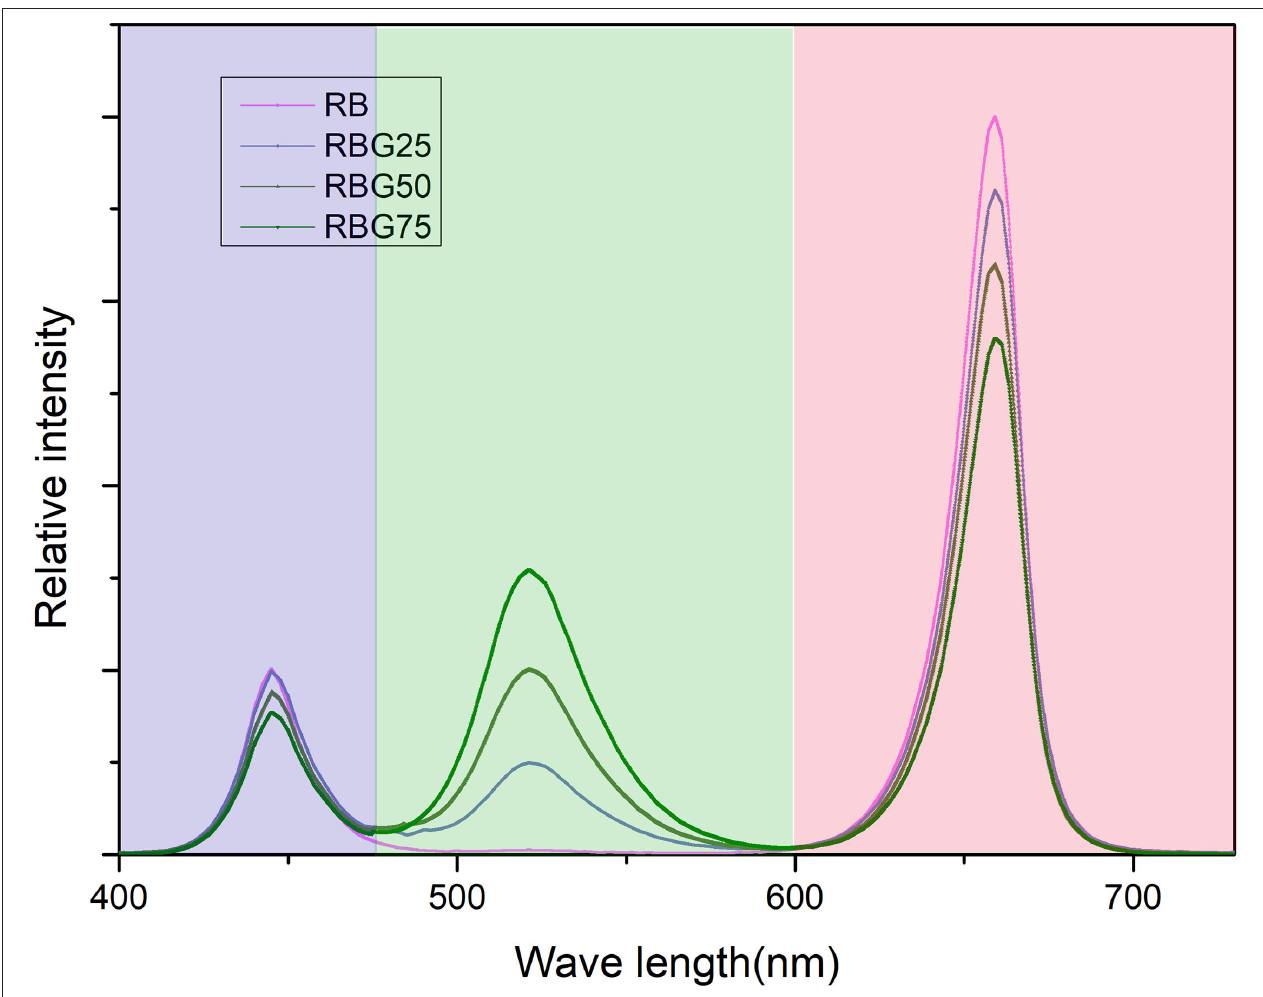
FIGURE 1 | The relative spectral distribution of four LED treatments measured at the top of the canopy. The four LED treatments contained red + blue (RB), red + blue + 25 µ mol m − 2 s − 1 green (RBG25), red + blue + 50 µ mol m − 2 s − 1 green (RBG50), red + blue + 75 µ mol m − 2 s − 1 green (RBG75) LEDs. Light qualities were indicated according to wavelengths: red (peak at 660nm), blue (peak at 450nm), and green (peak at 530nm). The photosynthetic photon flux density (PPFD) of all treatments was maintained at 250 µ mol m − 2 s − 1 . The red to blue (R/B) ratio of all treatments was 4:1.